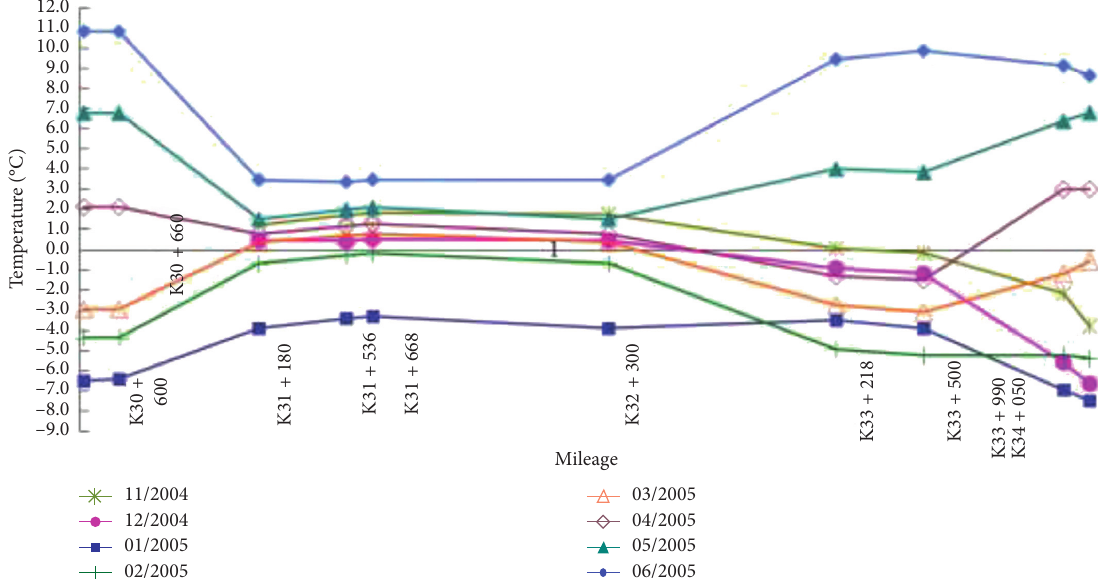
Figure 13: Air temperature distribution in longitude along the tunnel.